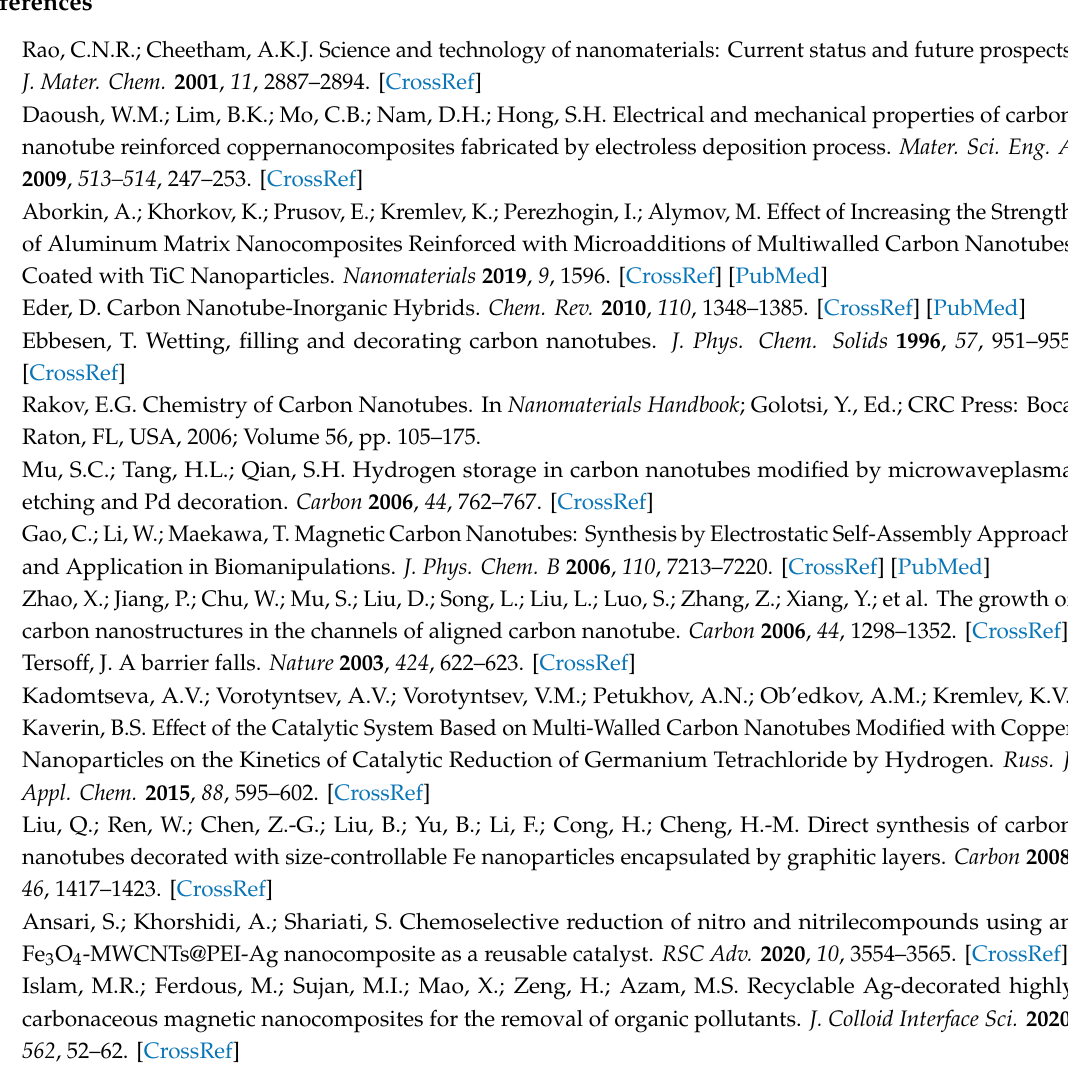
Figure S1: MOCVD-reactor for initial MWCNTs synthesis, Figure S2: MOCVD-reactor for Fe / MWCNTs composite synthesis, Figure S3: The scheme of all processing stages. Figure S4: Spectral dependences of the TEY signal of Cr / MWCNT and Fe / MWCNT nanocomposites, Figure S5: XPS spectra of the nanocomposites and the initial MWCNTs in a wide spectral range, Figure S6: XPS spectra of the Fe / MWCNTs nanocomposite and original